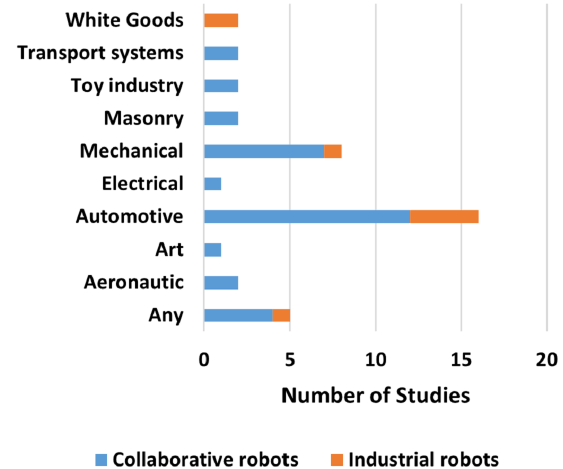
Figure 16. Number of studies by